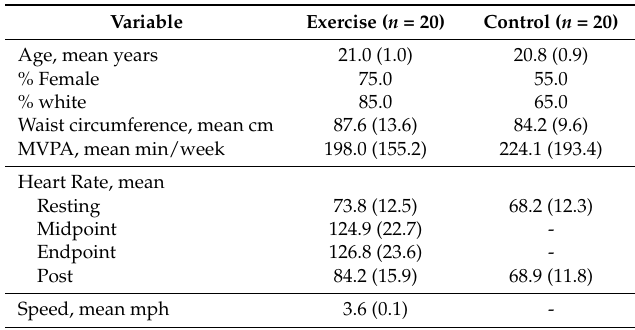
Table 1. Characteristics of the study variables.